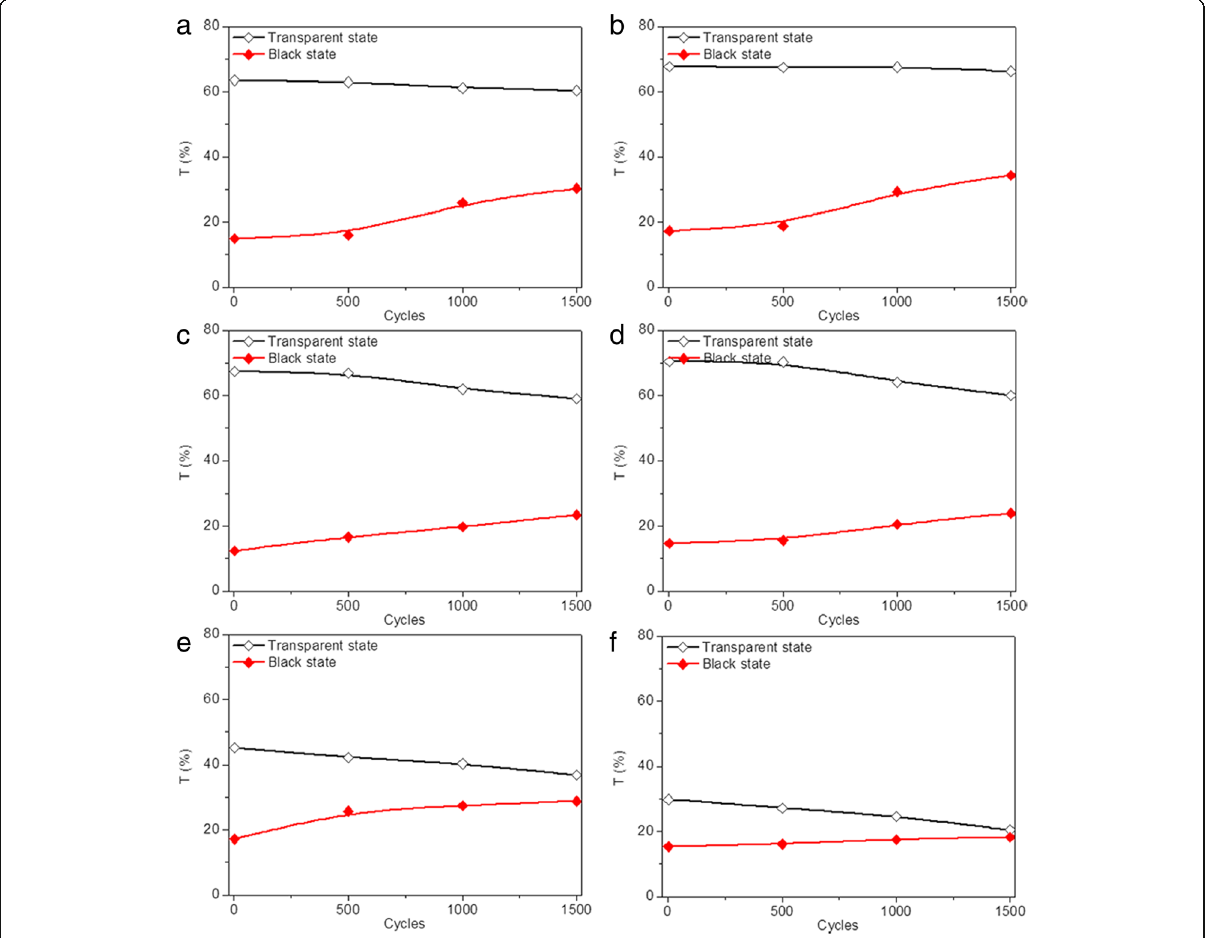
Fig. 10 (Color online) Transmittance variation for dip-coated devices in transparent ( black ) and black ( red ) states prepared with different modification conditions at 700 nm during two-electrode CV tests, including a , b different lifting speeds, c , d different precursor concentrations, and e , f different dipping numbers after applying sequential voltages in the following order: 2.5 V (10 s), 0.5 V (30 s), 2.5 V (10 s), and 0.5 V (20 s), with each of the 500 cycles taken as a measurement